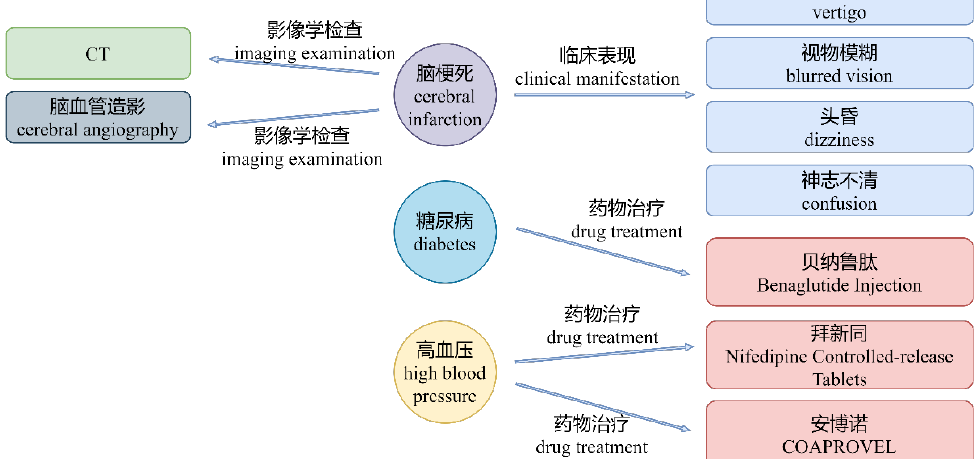
Figure 4. The results of the RC task in augmented data.